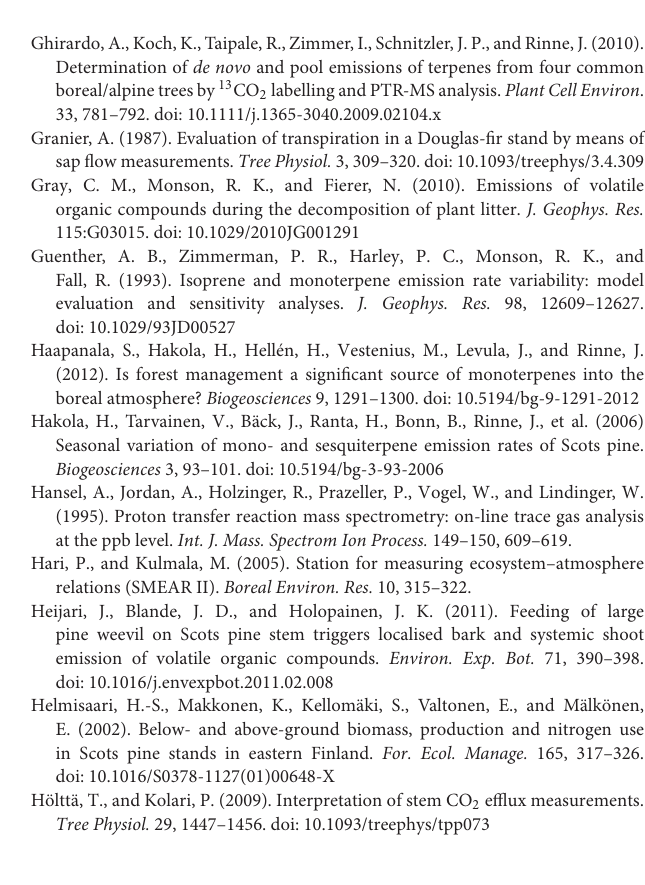
Figure S1 | The comparison between incident temperature measurements in enclosure No 2 and ambient temperature at 16m height between 2012 and 2014. Y-axis gives the proportion of measurements in each temperature difference range, indicating that most of the measurements fall into 0–2 ◦ C difference in